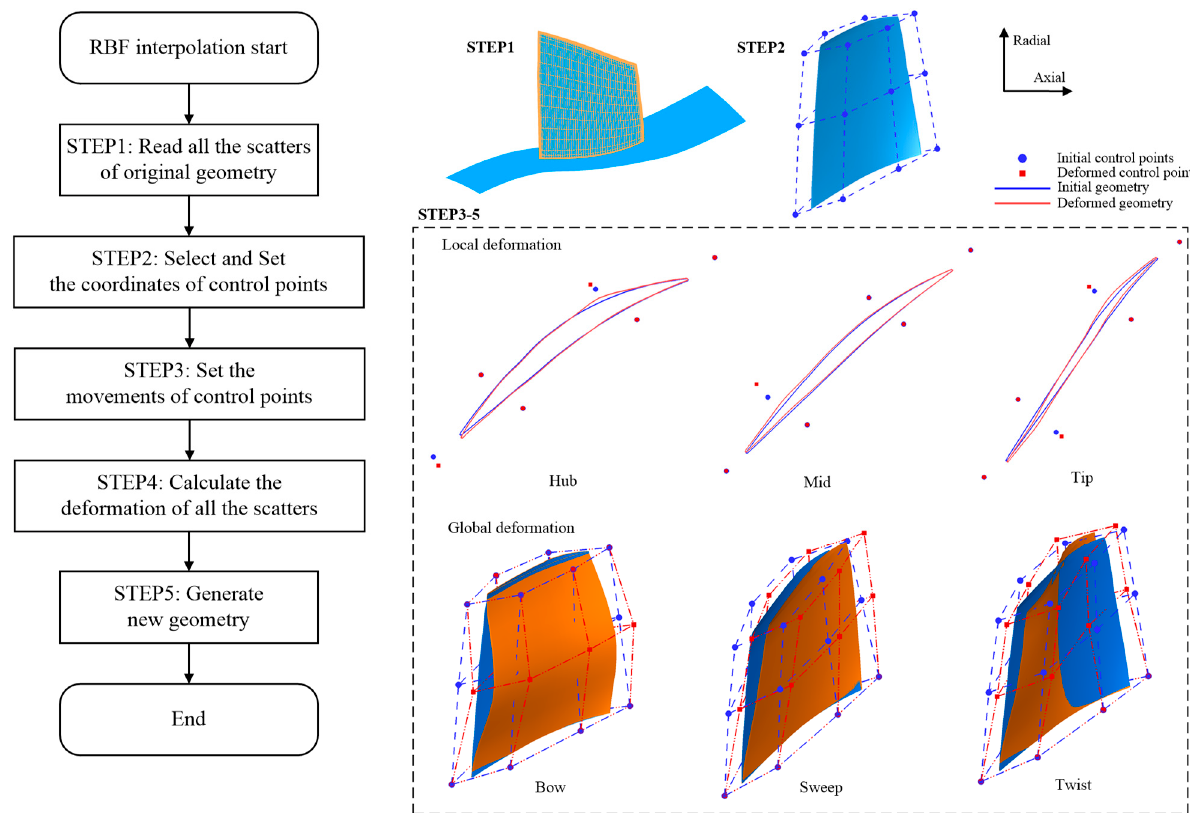
Figure 1. The flow chart deformation samples of RBF interpolation method.